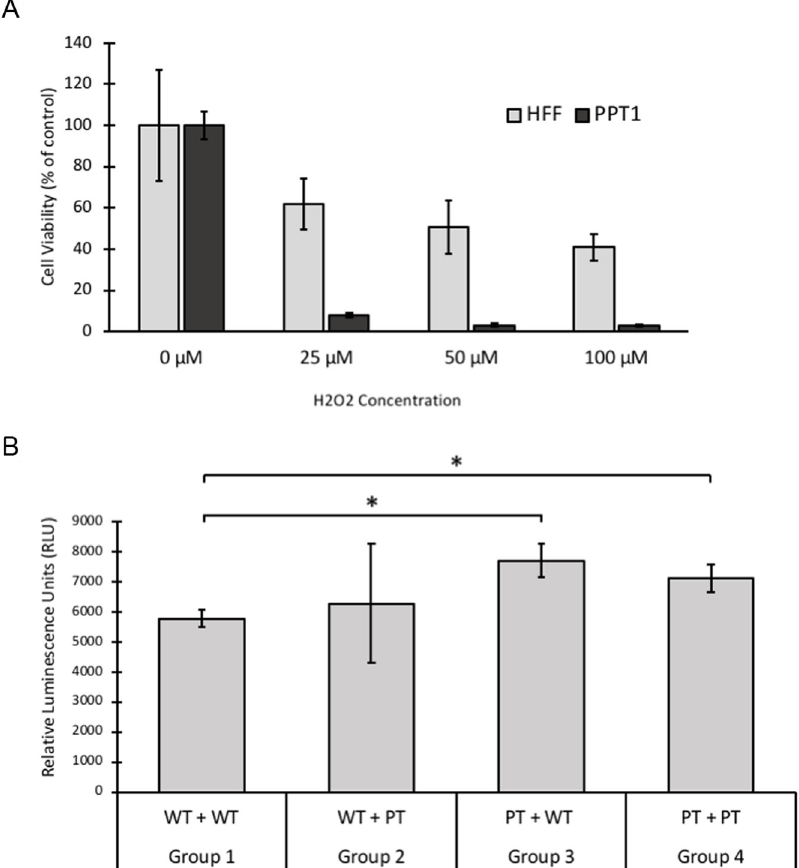
Fig 8. A. PPT1-deficient fibroblasts are more susceptible to hydrogen peroxide (H 2 O 2 ) induced cell death. HFF and PPT1-deficient fibroblasts were treated with 0, 25, 50, or 100 μ M H 2 O 2 for 24 hours. Cell viability was determined by MTT assay. PPT1-deficient cells displayed 8%, 3%, 3% of control viability with the increasing concentrations of 25, 50, and 100 μ M H 2 O 2 , respectively. HFF cells displayed 62%, 51%, and 41% of control viability under the same respective conditions. A significant group x dose effect was determined by ANOVA (p < 0.001). Group and dose effects individually were not significant (p = 0.071 and 0.054, respectively). Error bars display +SD. B. Detection of reactive oxygen species in four conditioned media groups. Intracellular levels of ROS were measured, in relative luminescence units (RLU), using a Spectramax M5 plate reader. A significant increase ( � , p < 0.01) in ROS was found in both PT cell groups compared to WT cells. Error bars represent +/-